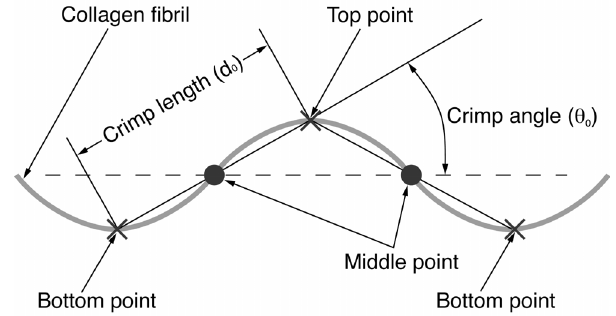
Definition of crimp parameters of collagen fibrils in the patellar tendon (12, 13)